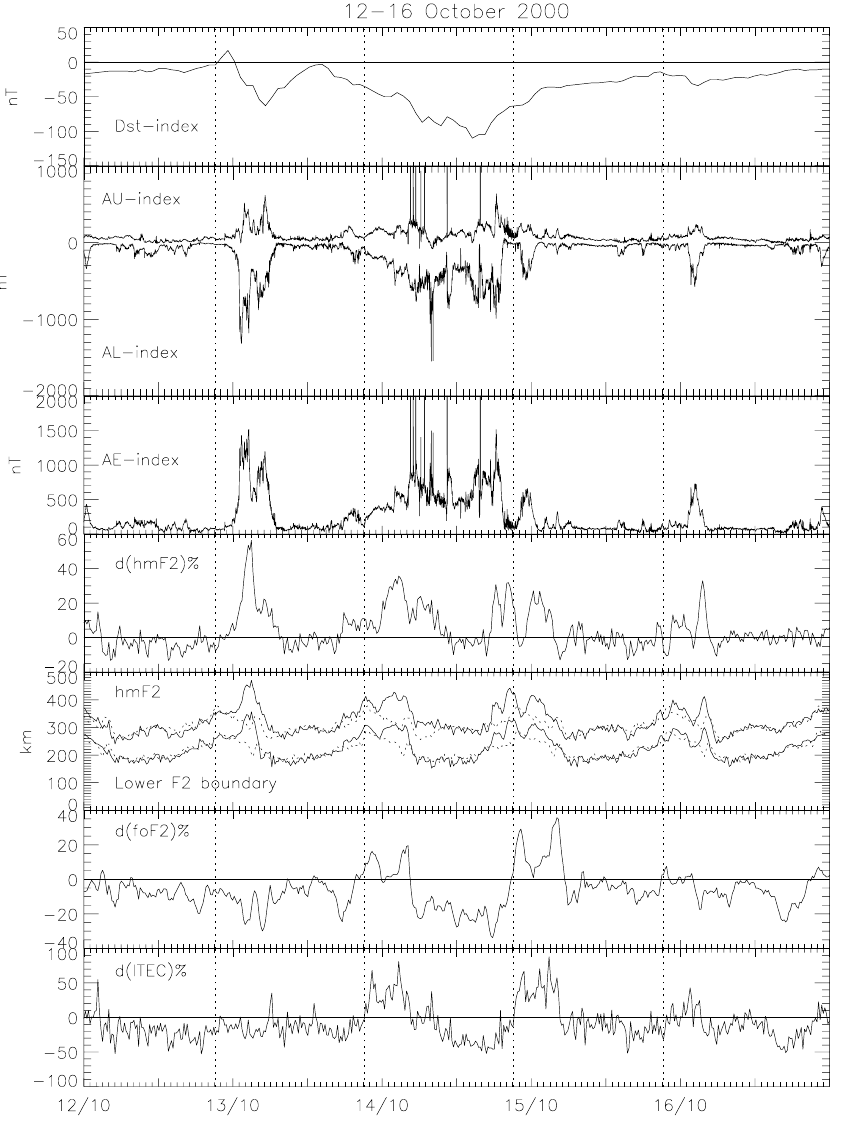
Fig. 2. Same as Fig. 1 for the interval 12–16 October